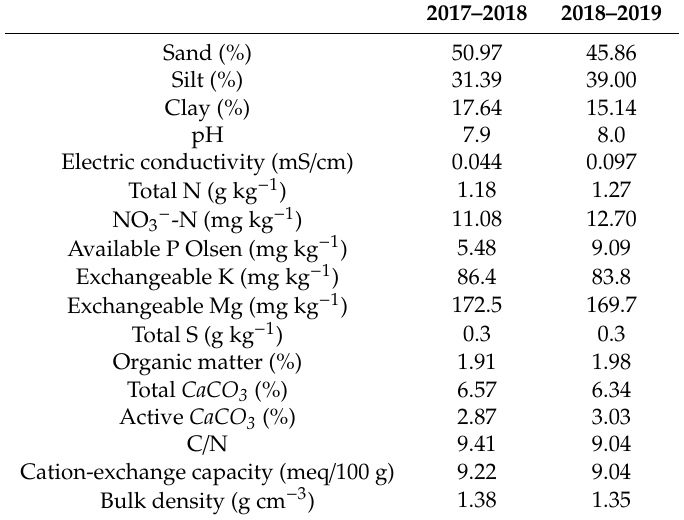
Table 1. Soil characteristics (0–30 cm depth) at the start of the